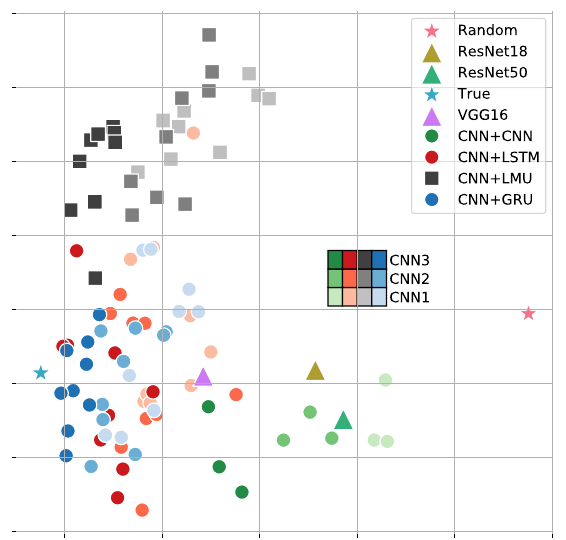
Figure 2. Comparison of models. A PCA plot showing aggregated test outputs ( ∈ R 100 ) of various models (see “Comparing models” section for details). The point True (green star, left-most along x-axis) denotes the correct 100 × 1 one-hot encoding test label output, while the Random point (right-most along x-axis) denotes the uniform probability (or maximum entropy) 100 × 1 output. The shades of the points indicate which particular CNN was used in the hybrid